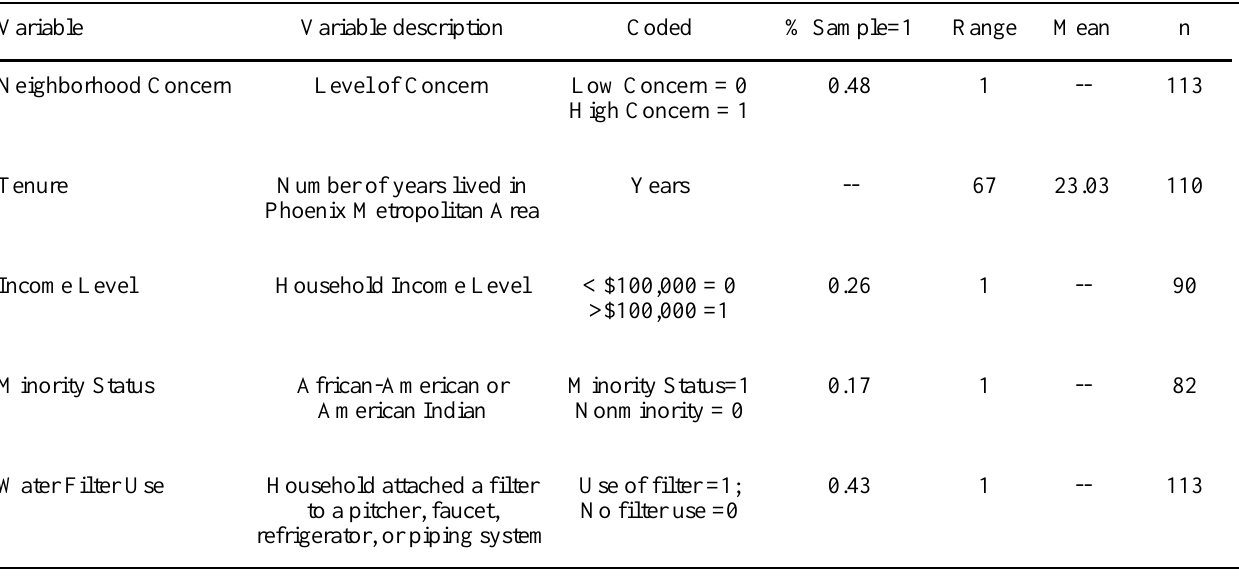
Table 1. Recoded variables and descriptive statistics. Because all variables are binary, % Sample indicates the percentage of respondents whose answers corresponded to